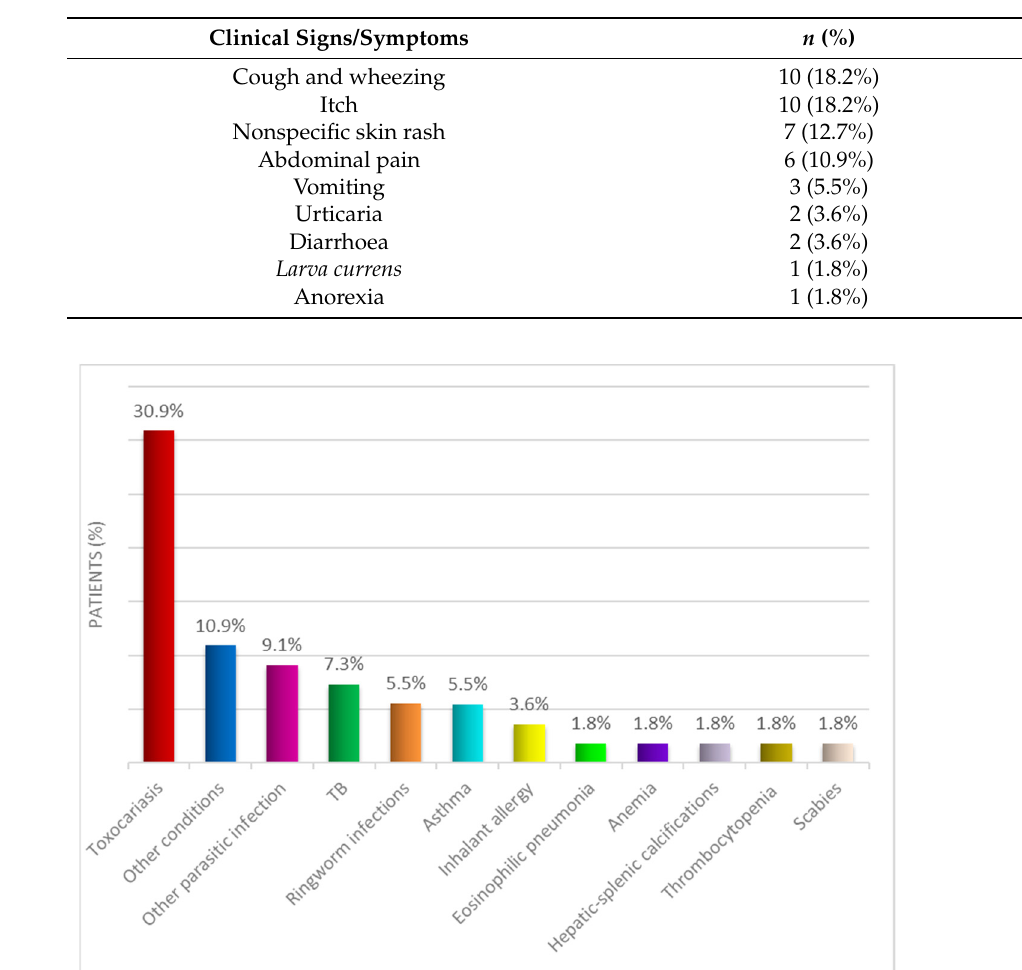
Table 3. Clinical features of patients who tested positive for S. stercoralis infection.